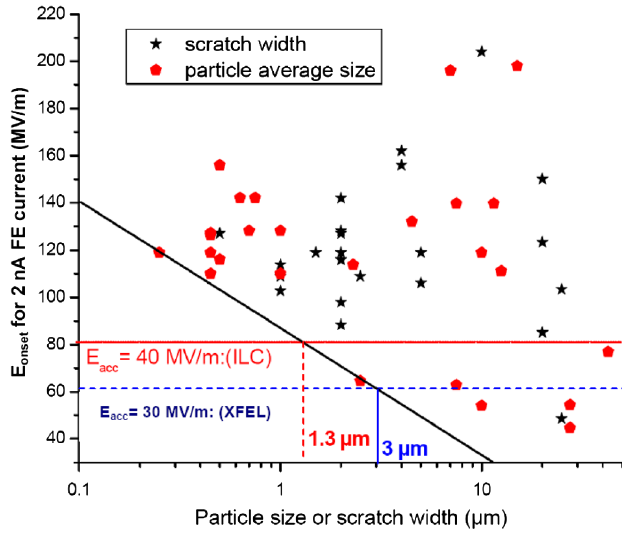
FIG. 7. (Color) Onset electric fields for 2 nA FE currents vs geometrical size of all identified emitters found on different polycrystalline/single crystal/large grain niobium samples. The horizontal lines correspond to the proposed accelerating fields for future accelerators XFEL and ILC, and the diagonal line sets a corresponding threshold for tolerable defect